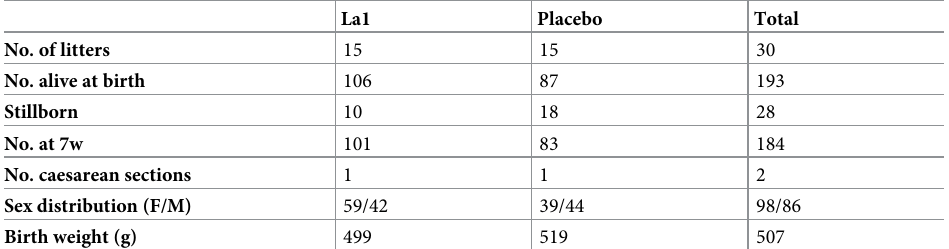
Table 1. Information of the study population with number of dogs in each treatment group (probiotic (La1) and